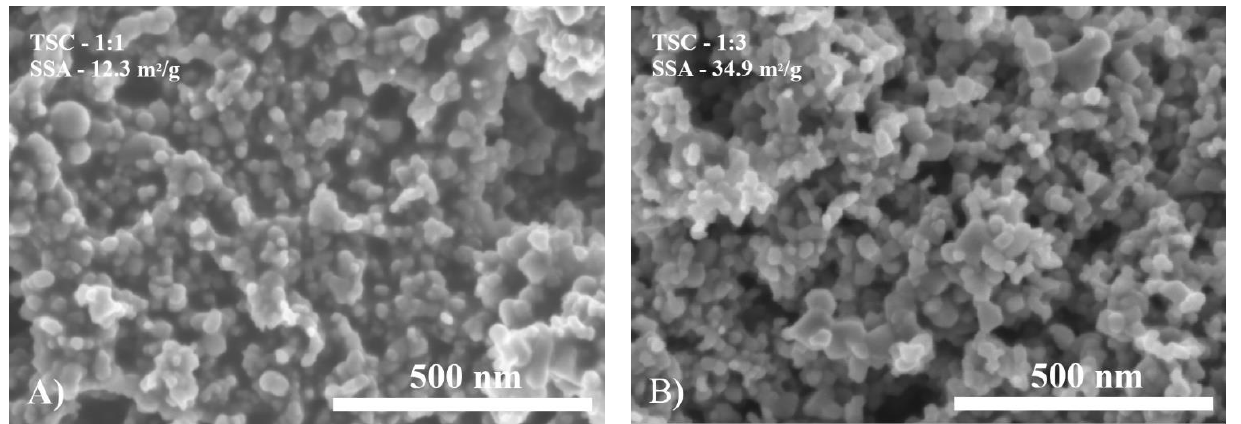
Figure 2. Multi-point BET plot for siloxane/TiO 2 with various ratio 1:1 and 1:3.